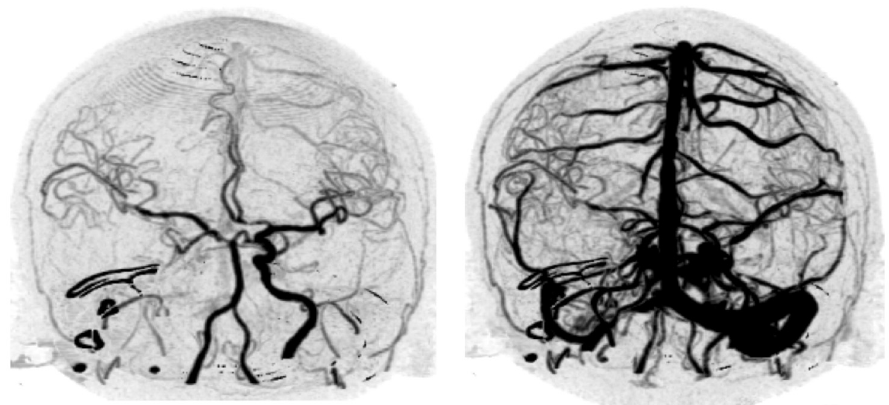
Figure 1. Unedited anteroposterior-view W4D-CTA images of Case 8. ( Left ) Arterial phase; ( Right ) Ar- terial and venous phase. W4D-CTA, whole-brain four-dimensional computed tomography angiography.